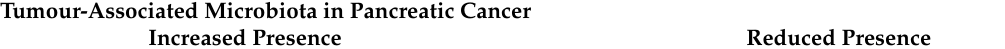
Table 2. Principal microbiological fundings in pancreatic cancer